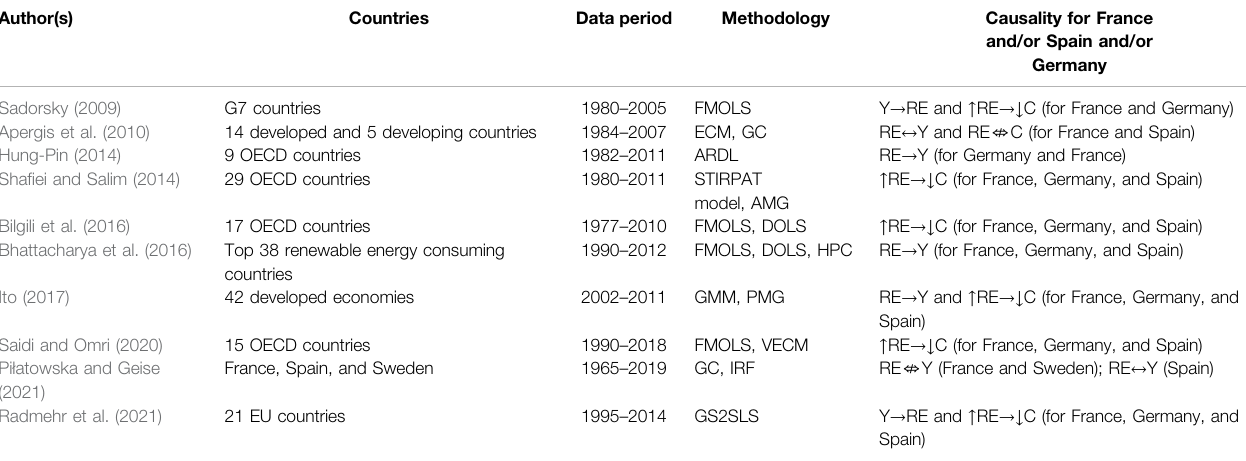
TABLE 2 | Summary of previous renewable energy-GDP nexus